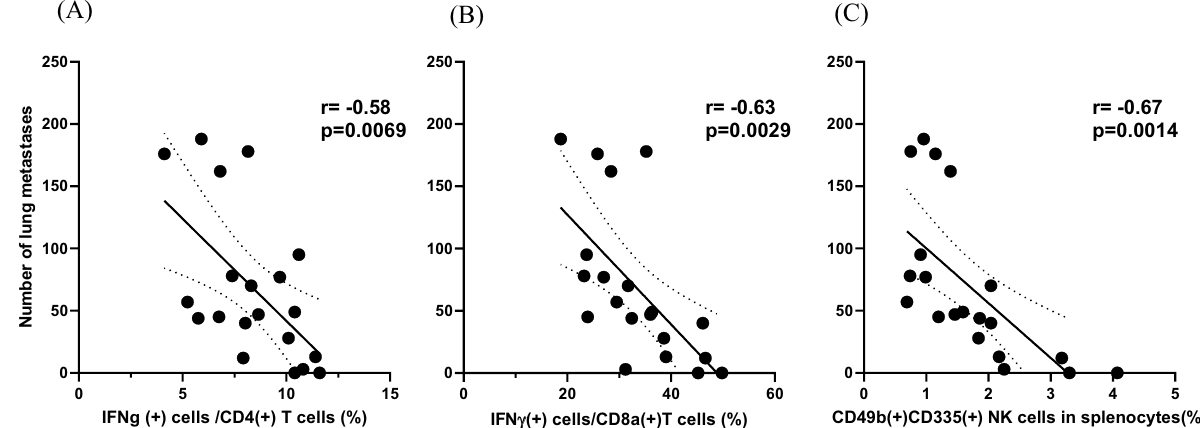
Figure 7. The correlation between the number of lung metastases and the ratios of IFN-γ (+) cells in CD4(+) ( A ) or CD8(+) T ( B ) cells as well as CD49b(+)CD335(+) NK ( C ) cells were evaluated with Pearson’s correlation